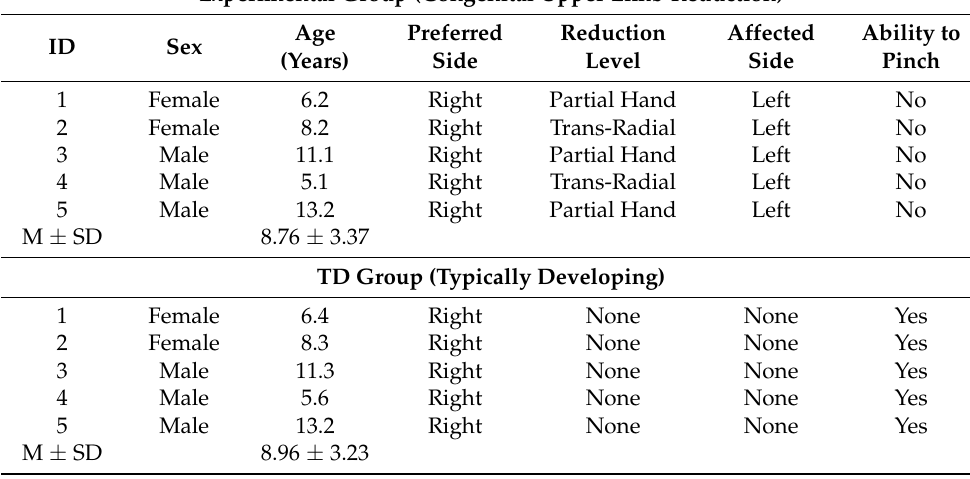
Table 1. Participant characteristics ( n =